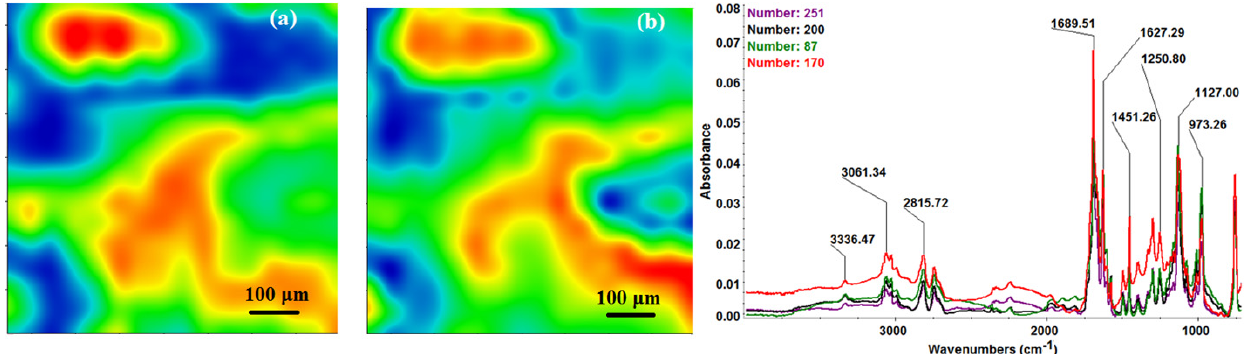
Figure 6. Second derivate IR mappings and IR spectra of Fe substrate: intensity distribution of ( a ) 2815 cm